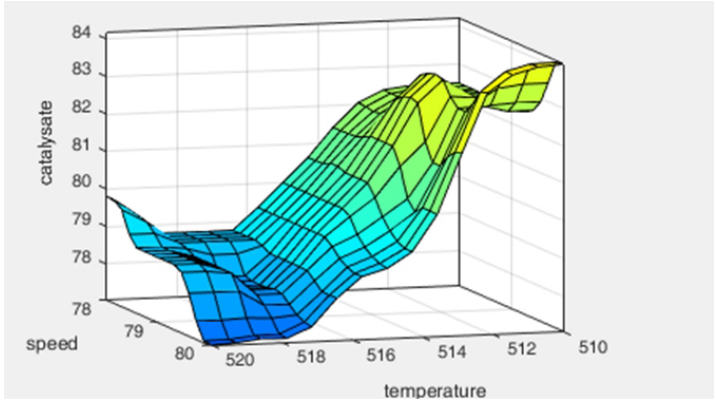
Figure 7. The surface of fuzzy